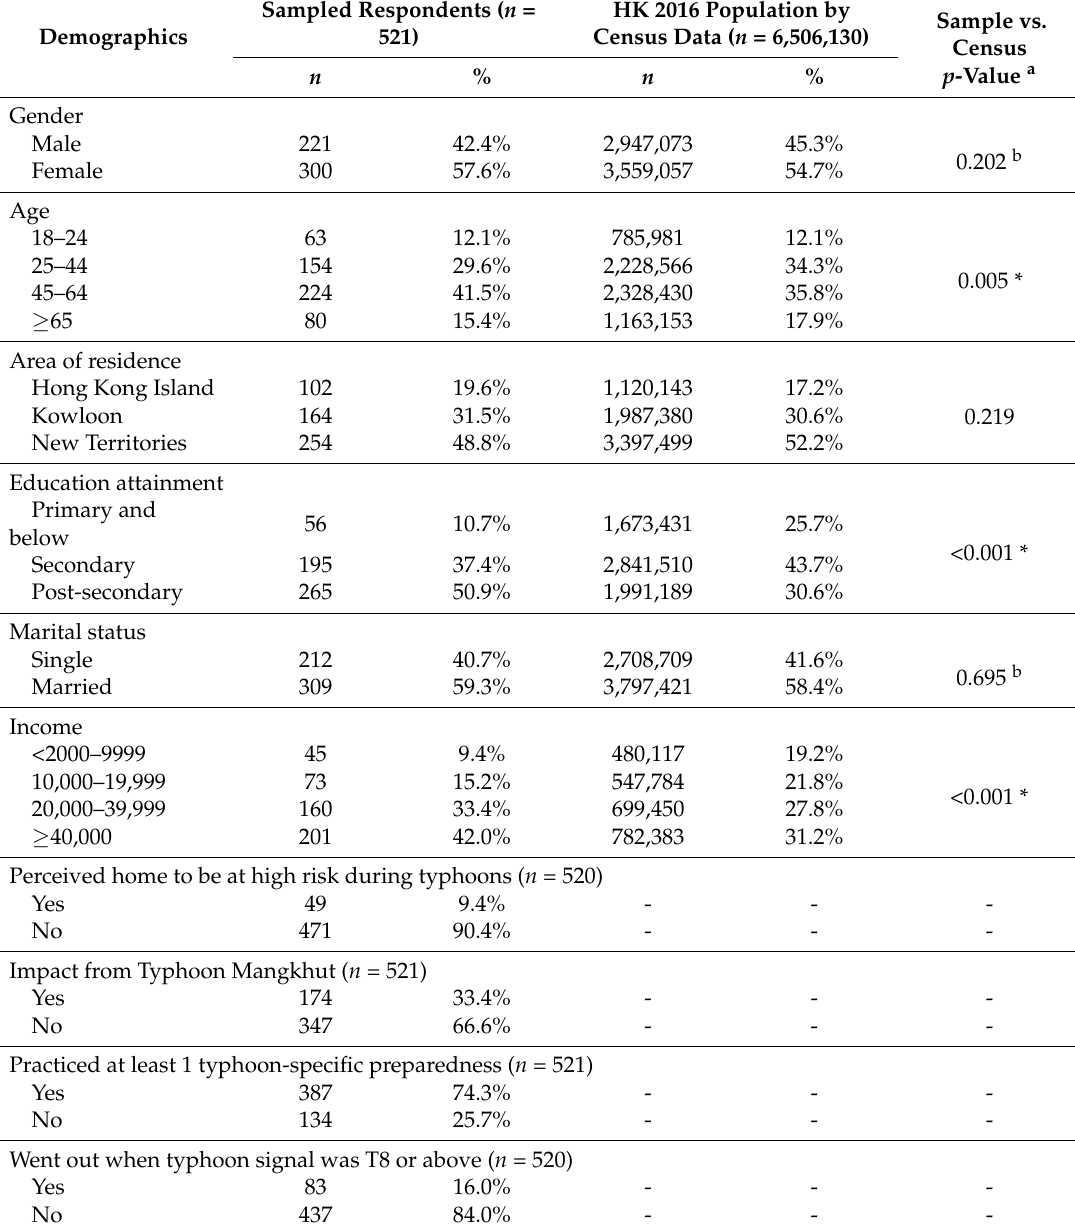
Table 2. The descriptive statistics about demographics, perception, preparedness, and